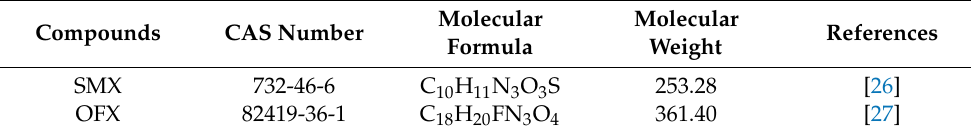
Table 2. Characteristics of antibiotics used in this